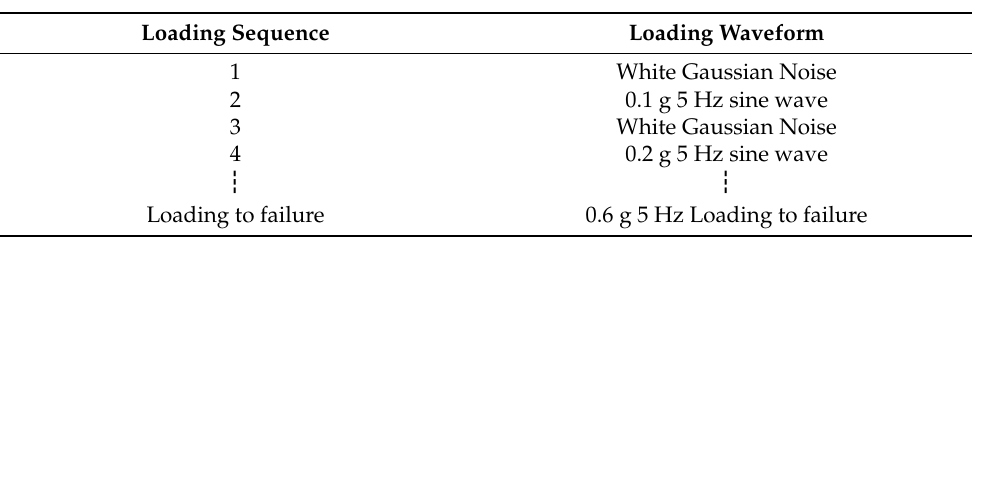
Figure 6. 5 Hz sine wave waveform and Fourier spectrum